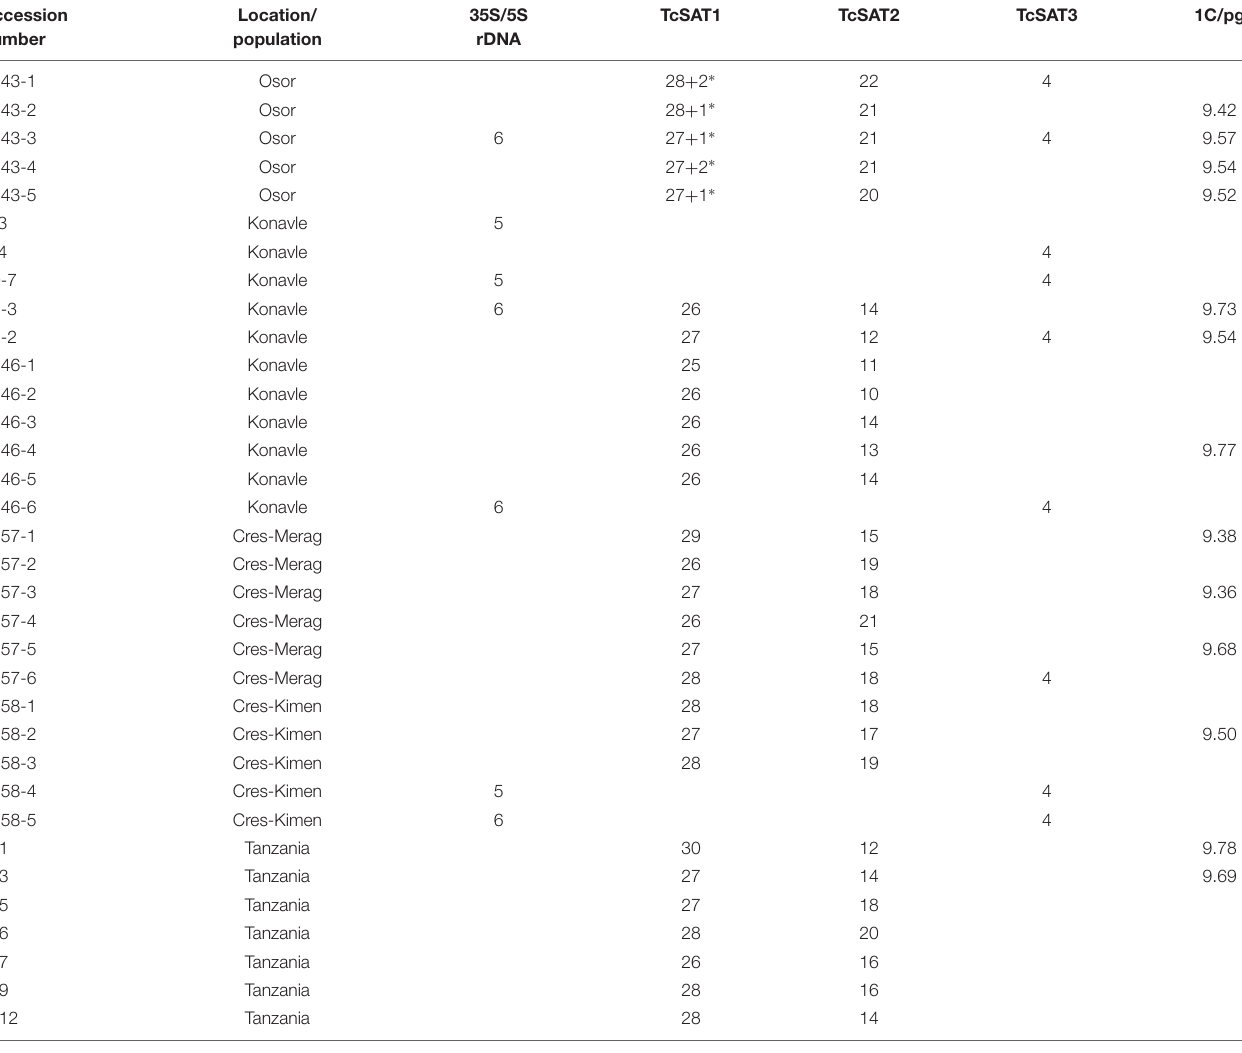
TABLE 1 | Accession number, location, geographic origin and number of rDNA and satellite DNA sites in plants investigated in this